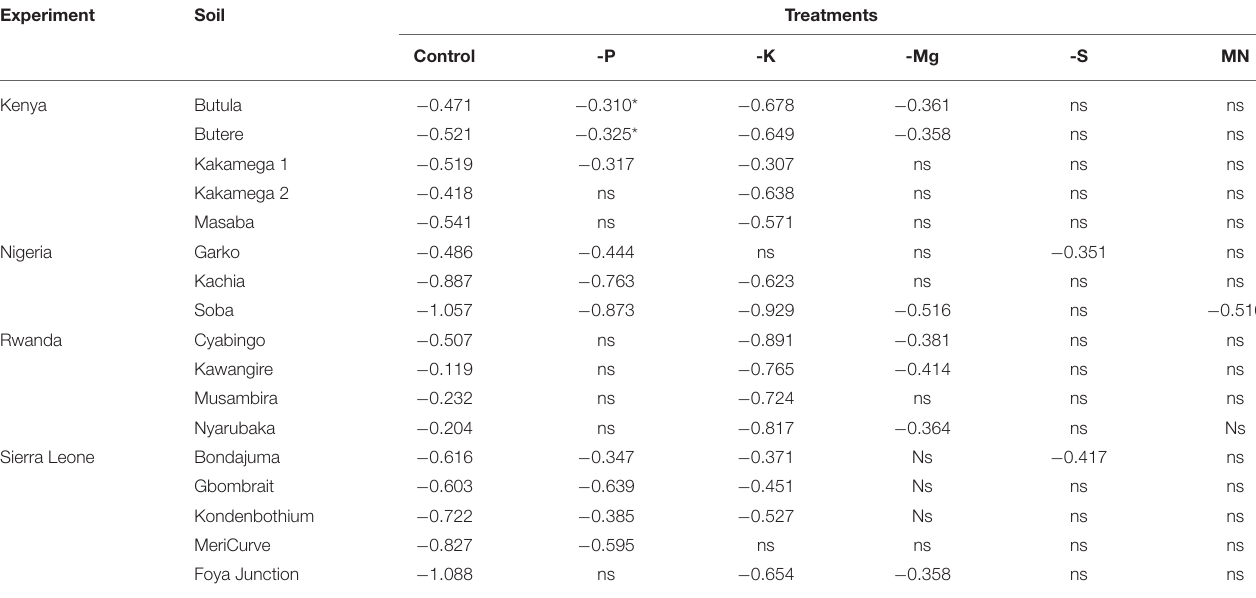
TABLE 7 | Averages of log biomass of control and omitted nutrients (relative to Complete) that were significantly below zero (0) ordered per experiment soil, ns = not significant.